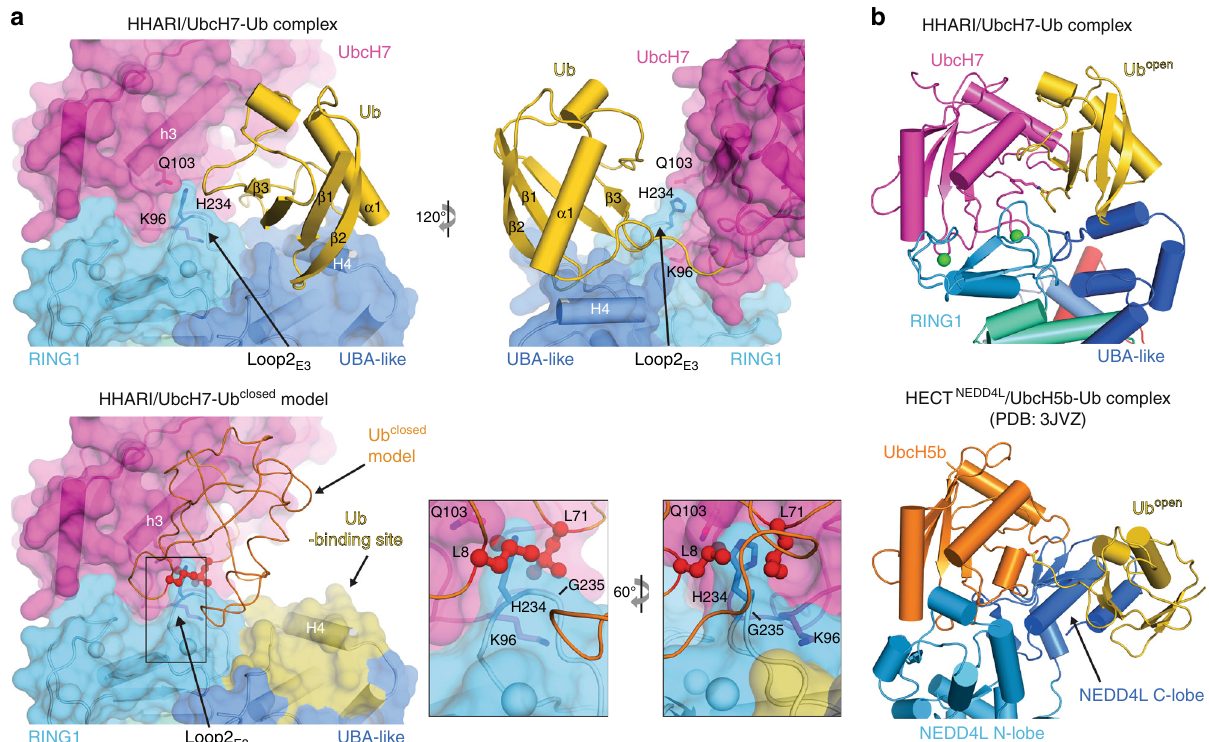
Fig. 5 Molecular basis for HHARI recruitment of E2 ~ Ub in the open conformation. a ( top ) HHARI and UbcH7 from the HHARI/UbcH7-Ub structure are shown as cartoon representations with semitransparent surfaces. Ub is shown as a cartoon representation. Selected residues are shown as sticks. ( bottom ) A HHARI/UbcH7-Ub model with UbcH7-Ub in the ‘ closed ’ conformation shown in the same orientation as the top panel. The model was prepared by superimposing UbcH5b-Ub in the closed conformation ( orange ) (PDB: 4V3K) onto UbcH7 from the HHARI/UbcH7-Ub structure. The surface of the HHARI UBA-like domain that interacts with the core of Ub from the HHARI/UbcH7-Ub structure is colored yellow . Loop2 E3 of HHARI is boxed and two magni fi ed views of this region are shown in the insets . The two Ub residues that clash most severely with HHARI Loop2 E3 in the closed conformation are colored red and shown as ball and sticks . b Comparison of the HHARI/UbcH7-Ub (left) and HECT NEDD4L /UbcH5b-Ub ( right ) complexes. Structures are shown as cartoon representations in the same orientation with proteins and domains labeled and